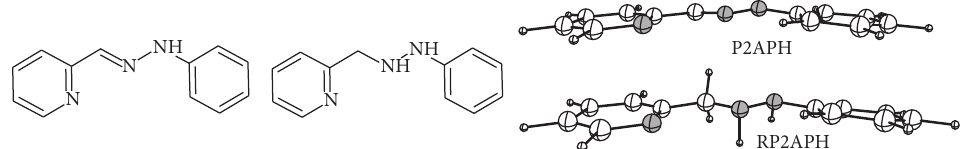
Figure 1: Structure of P2APH and RP2APH and their optimized geometries.